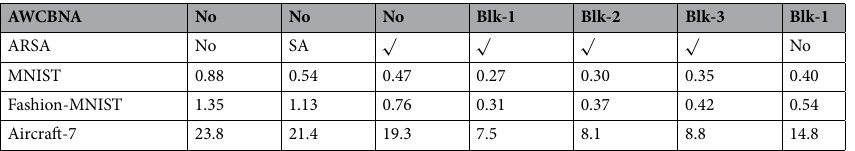
Table 2. Ablation study on datasets of MNIST, Fashion-MNIST, and OPT_aircraft-7, Blk-n means to add AWCBNA after the n-th ResBlk feature maps, and the best FID report.